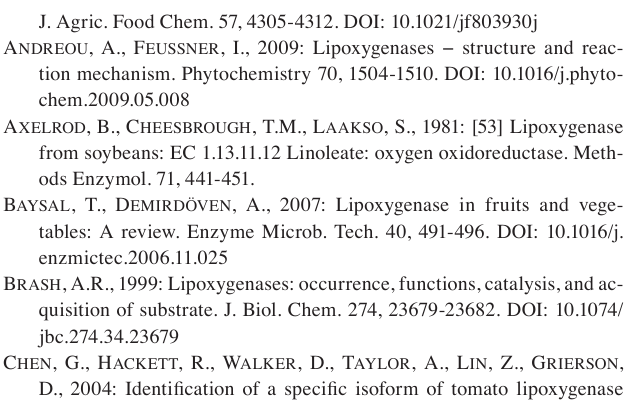
Fig. 5: LOX activity and gene expression in pulp during fruit softening at shelf life. (A) Respiration rate; (B) ethylene production rate; (C) firmness; (D) LOX activity; (E) and (F) expression of PcLOX1 and PcLOX7 genes. Data are the means ± SE of three replicates. The vertical bars represent the standard errors of the means. The ‘*’ represents a significant difference ( P <